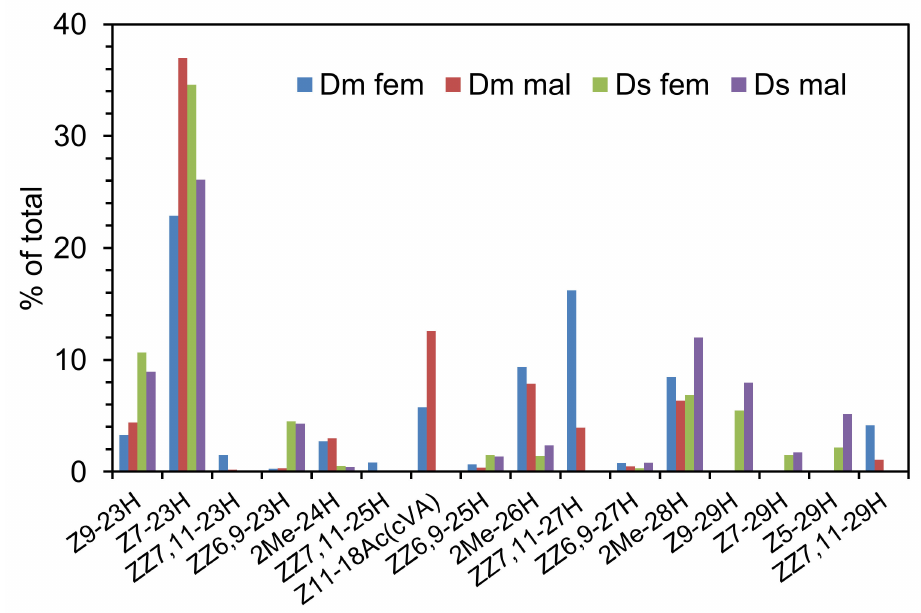
Figure 12. Relative amounts (% of total) of compounds identified in hexane extracts of adult females (Dmfem) and males (Dmmal) of Drosophila melanogaster and females (Dsfem) and males (Dsmal) of D. suzukii. See text for compound abbreviations.